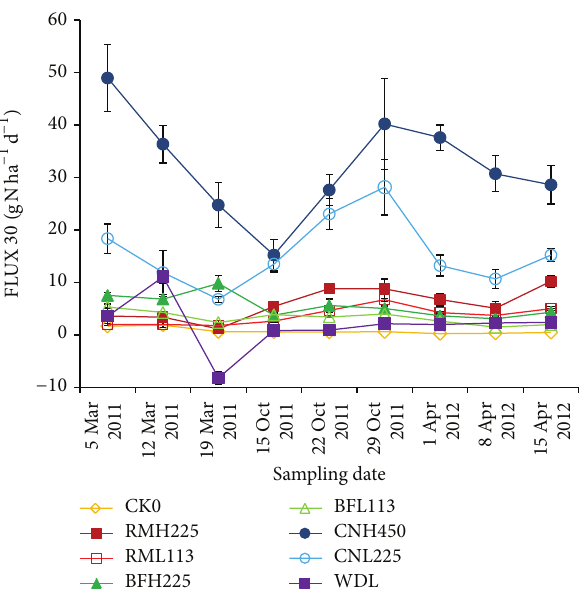
Figure 2: Variations in soil N 2 O flux in tea fields during 2011-2012 (CK0: unfertilized; RMH225: raw materials applied at 225 kg N ha −1 yr −1 ; RMH113: raw materials applied at 113kg Nha −1 yr −1 ; BFH225: biofertilizer applied at 225 kg Nha −1 yr −1 ; BFH113: biofertilizer applied at 113kg N ha −1 yr −1 ; CNH450: urea applied at 450 kg N ha −1 yr −1 ; and CNH225: urea applied at 225 kg N ha −1 yr −1 ,